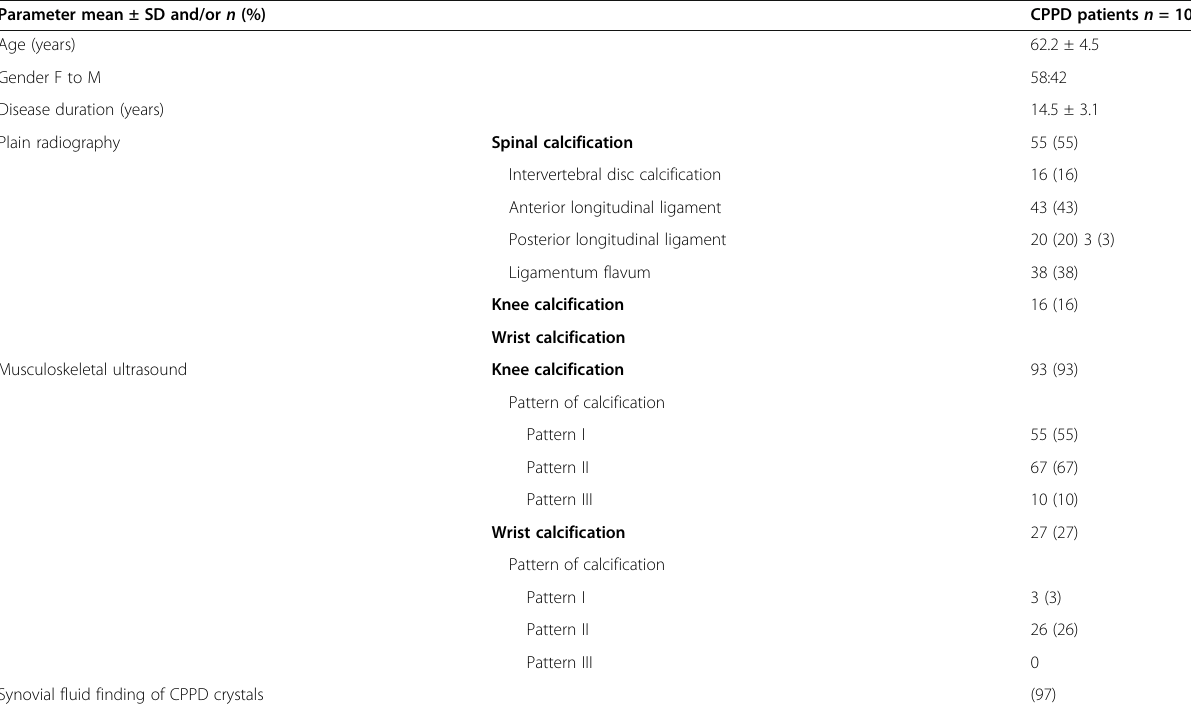
Table 1 Characters of CPPD deposition disease patients, plain radiography, and MSUS detection of calcifications and synovial fluid finding of CPPD crystals in studied group Parameter mean ± SD and/or n